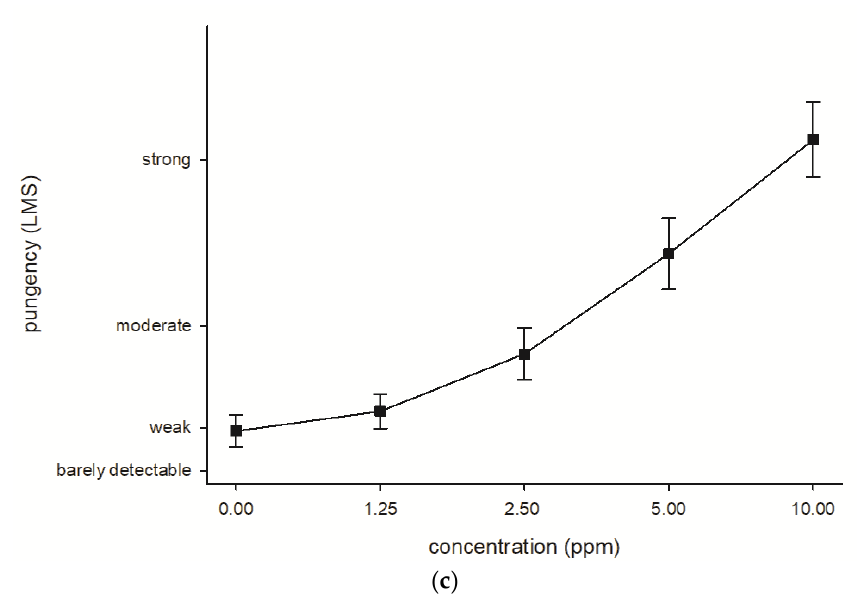
Figure 4. Impact of different concentrations of ammonia on perceived ( a ) hedonic value, ( b ) odor intensity and ( c ) pungency (mean ± SEM).